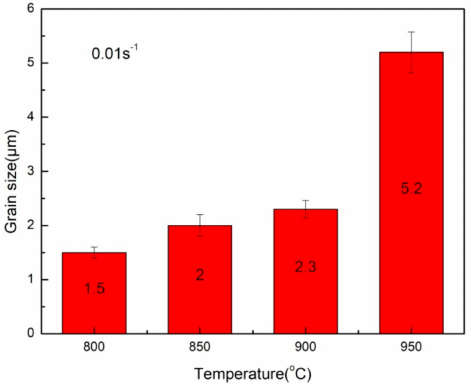
Figure 6. α grain size vs. deformation temperature. The strain rate is 0.01 s − 1 .